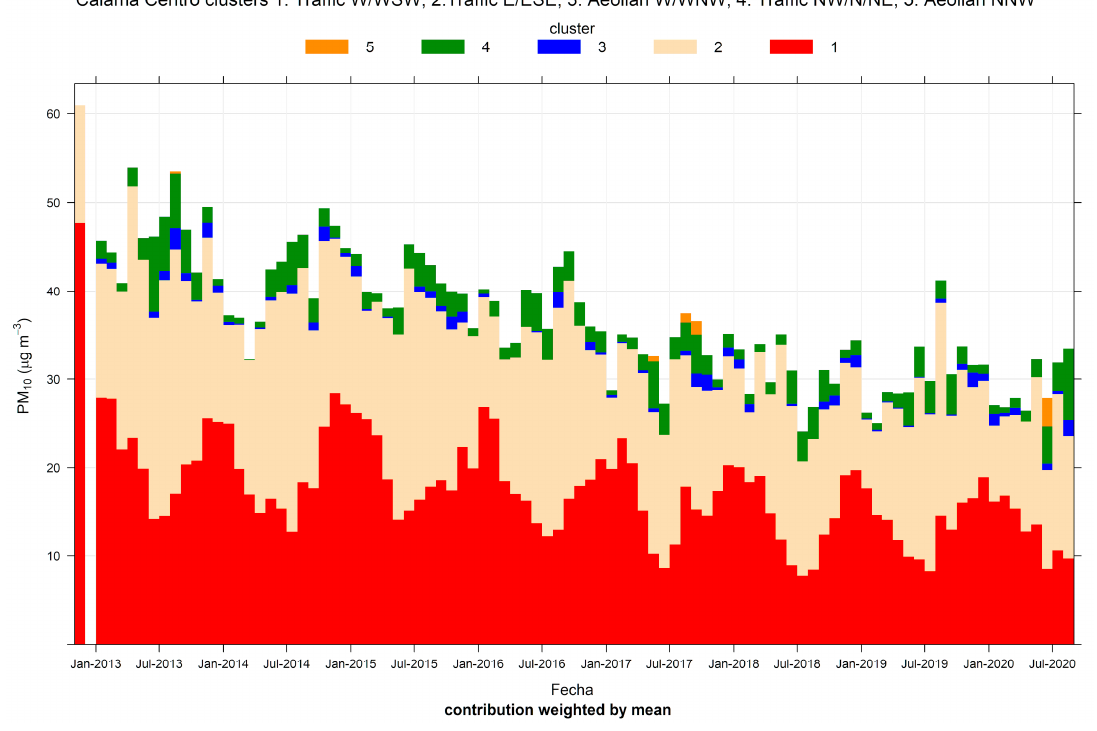
Figure 3. Cluster analysis source apportionment results for ambient PM 10 at Calama, 2012/10–2020/08, for a 5-cluster solution.